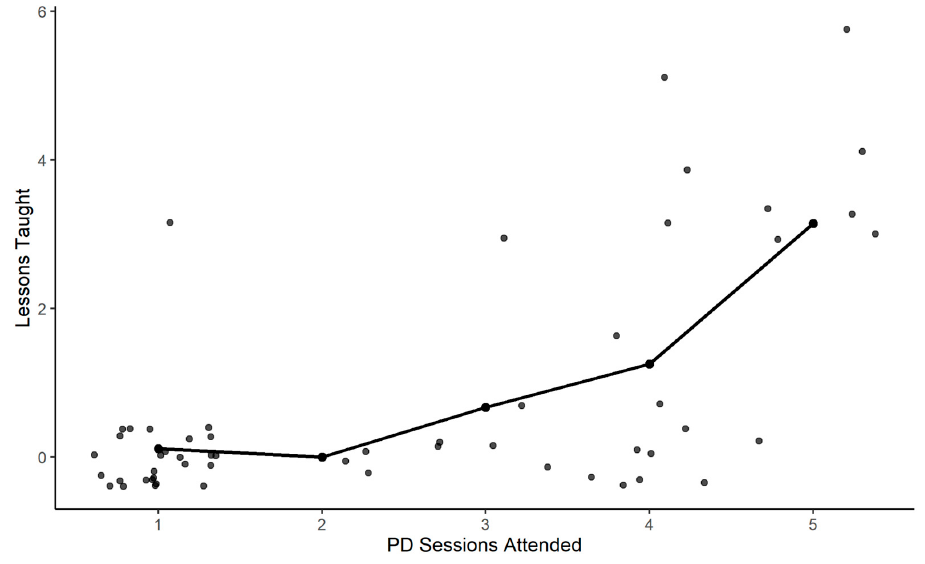
Figure 1. Correlation between professional development sessions and nutrition lesson implementa- tion.